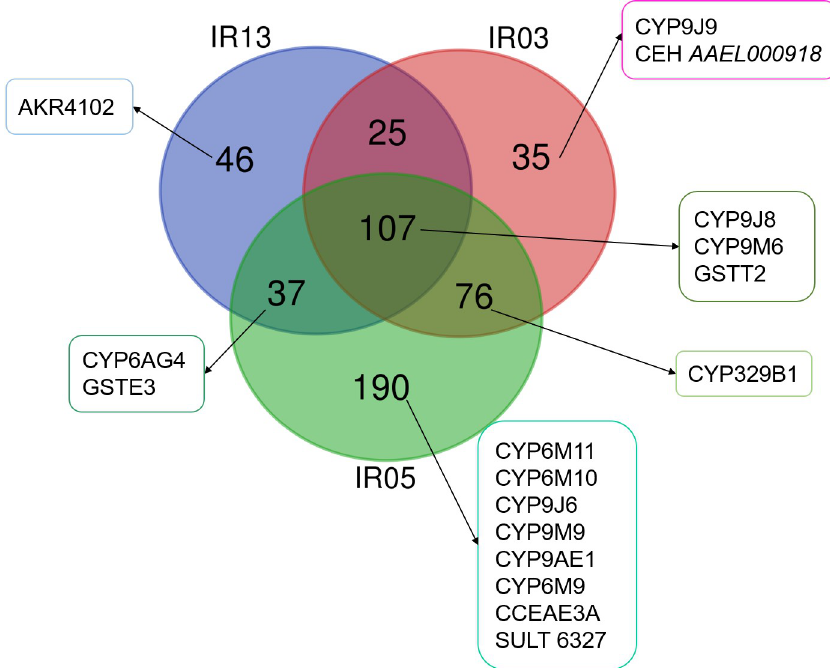
Fig 5. Venn diagram representing the proteins more abundant in NO reference strain when compared to either IR13, IR03 or IR05 strains. The identified proteins belonging to the cytochrome P450 family (CYPs), esterase family (CCE or CEH), GST family, aldo-keto reductase (AKR) and sulfotransferase (SULT) were highlighted in the different conditions.